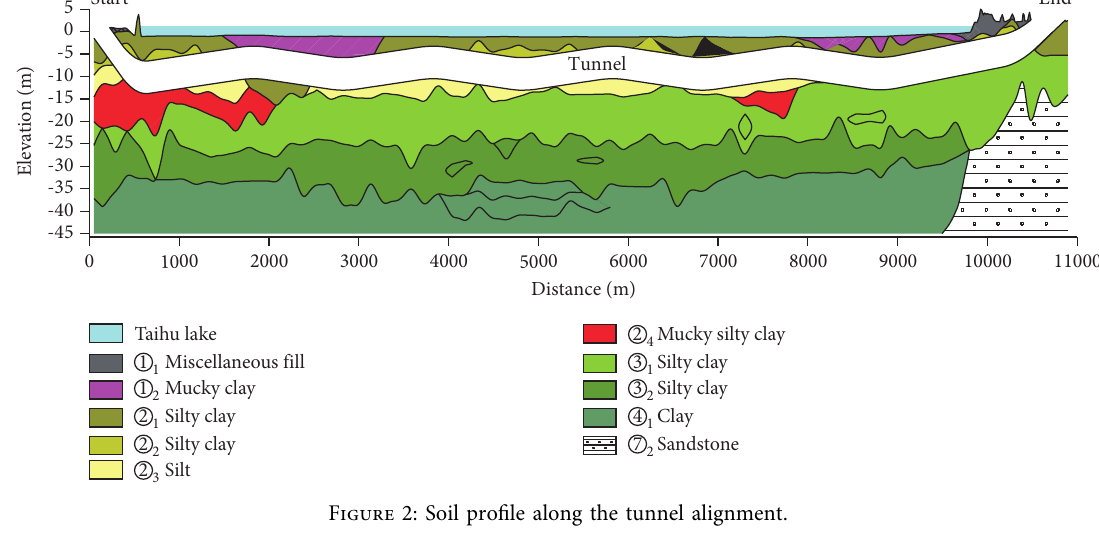
Figure 2: Soil profile along the tunnel alignment.